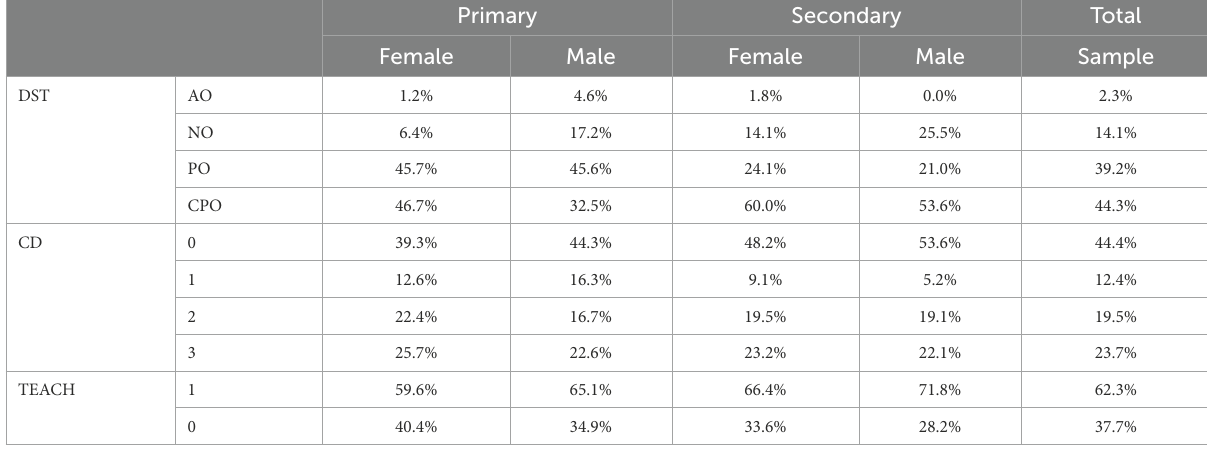
TABLE 1 Frequencies of Drawn Stories Technique outcomes and classroom drawing scores.